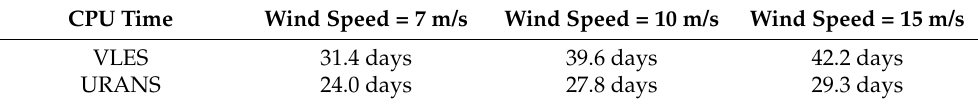
Table 10. Comparison of the CPU times used by URANS and VLES